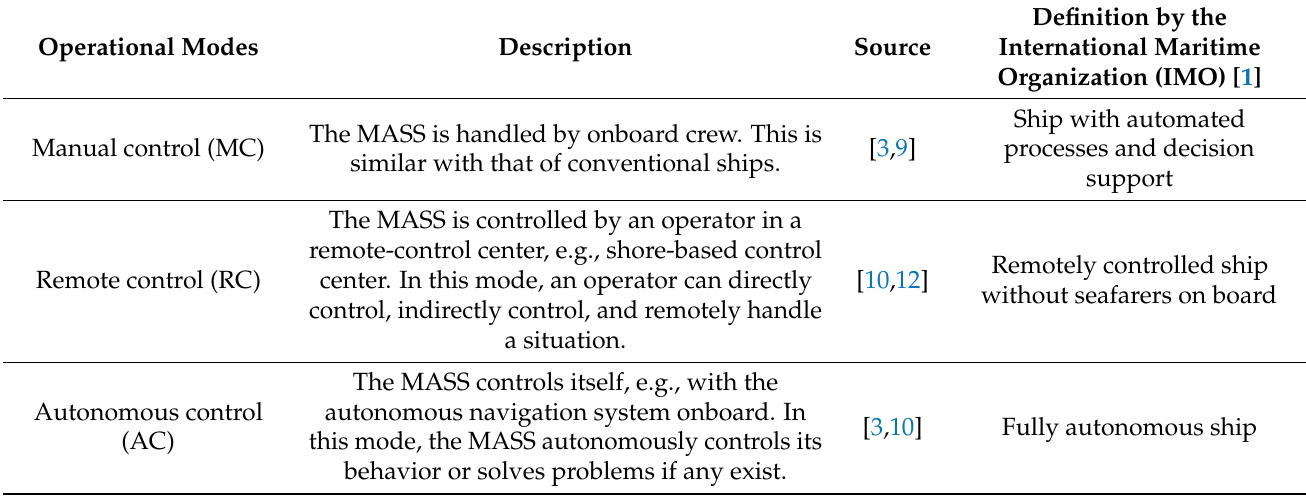
Table 1. Three operational modes (Oms) in this